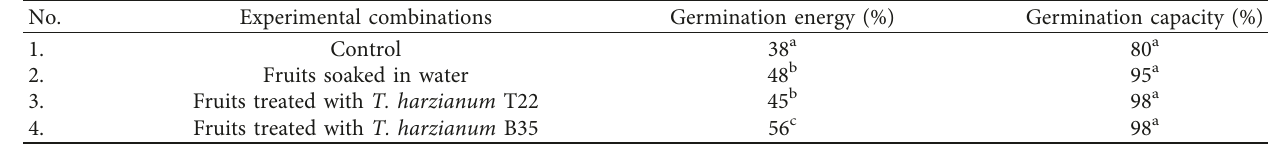
Table 1: Germination energy and capacity of the coriander fruits (%).